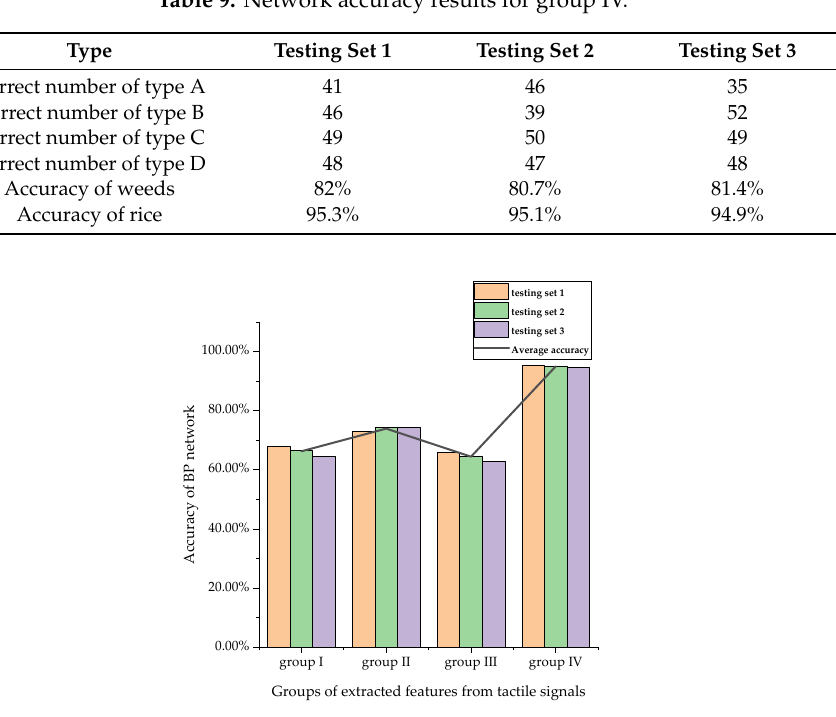
Figure 7. Resulting plot of the comparison of recognition rate before and after using the genetic algorithm.